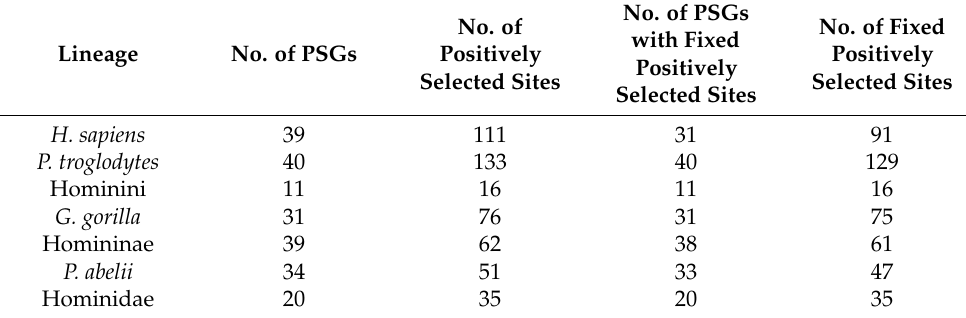
Table 3. Most of the PSGs were fixed in population.